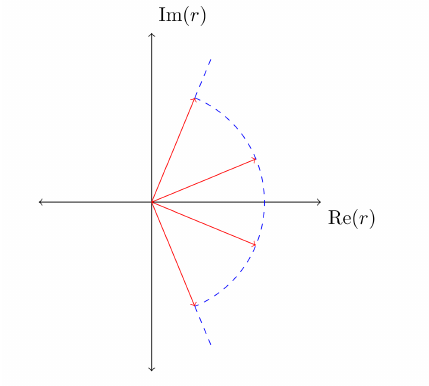
Figure 3 . Schematic representation of the small arc-shaped portion of the big contour, in the surroundings of r = 0 , as the blue dashed line. The Stokes lines are represented by red curves. Naturally, not all Stokes lines are